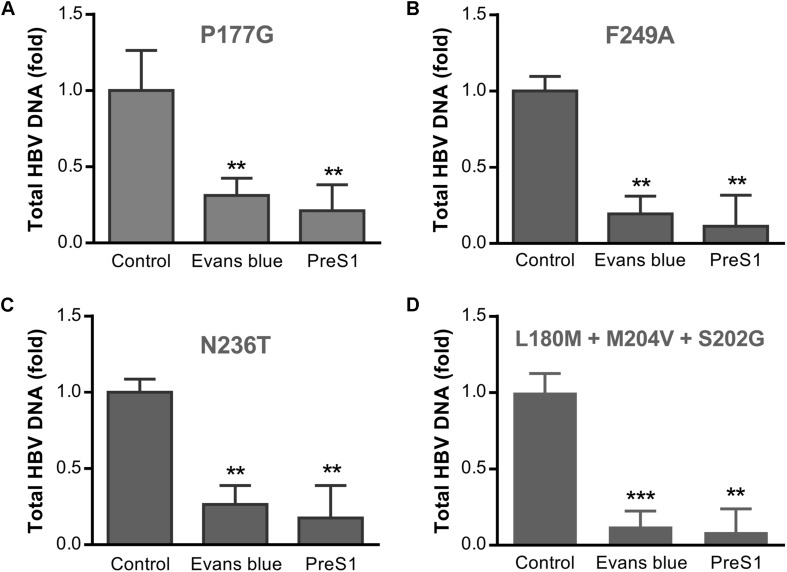
Evans blue inhibits the infection of drug-resistant strains of HBV. Huh7 cells transfected with an HBV plasmid carrying drug resistance mutation(s) as described in Section “Materials and Methods” were cultured in DMEM media for 4 days. The supernatant virions were collected and used to infect Huh7DhNTCP cells at Geq = 2000. Six days after infection, total HBV DNAs were extracted for PCR analysis. Drug-resistant mutations P117G (A) and F249A (B) are tenofovir resistant, N236T (C) is adefovir resistant, and L180M + M204V + S202G is 3TC/ETV-dual-resistant (D). Statistical significance was determined using Two tails Student’s t-test (∗P < 0.05, ∗∗P < 0.01, ∗∗∗P < 0.001).